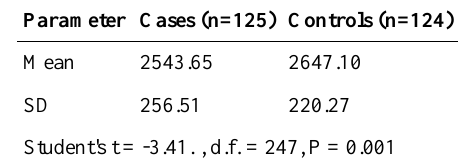
Figure.2: Scatterplot diagram showing correlation between endothelial cell count and duration of DM in